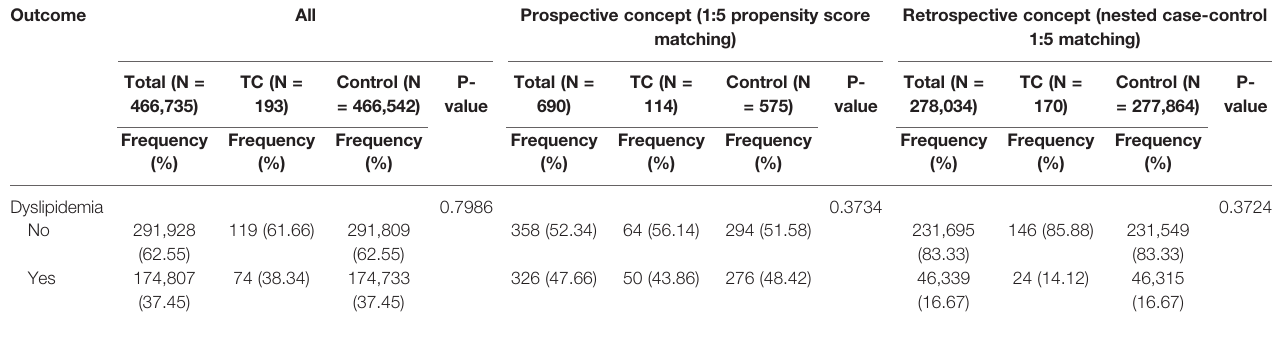
TABLE 3 | Comparison of dyslipidemia incidence between the patients with thyroid cancer and controls. Outcome All Prospective concept (1:5 propensity score